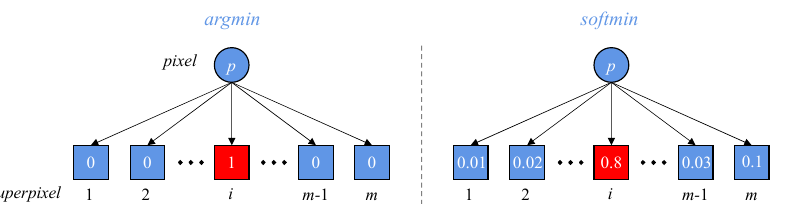
Figure 5. Illustration of the different between argmin and softmin. In the argmin strategy, a pixel is assigned to a superpixel. In the softmin strategy, pixels are assigned to surrounding superpixels in the form of